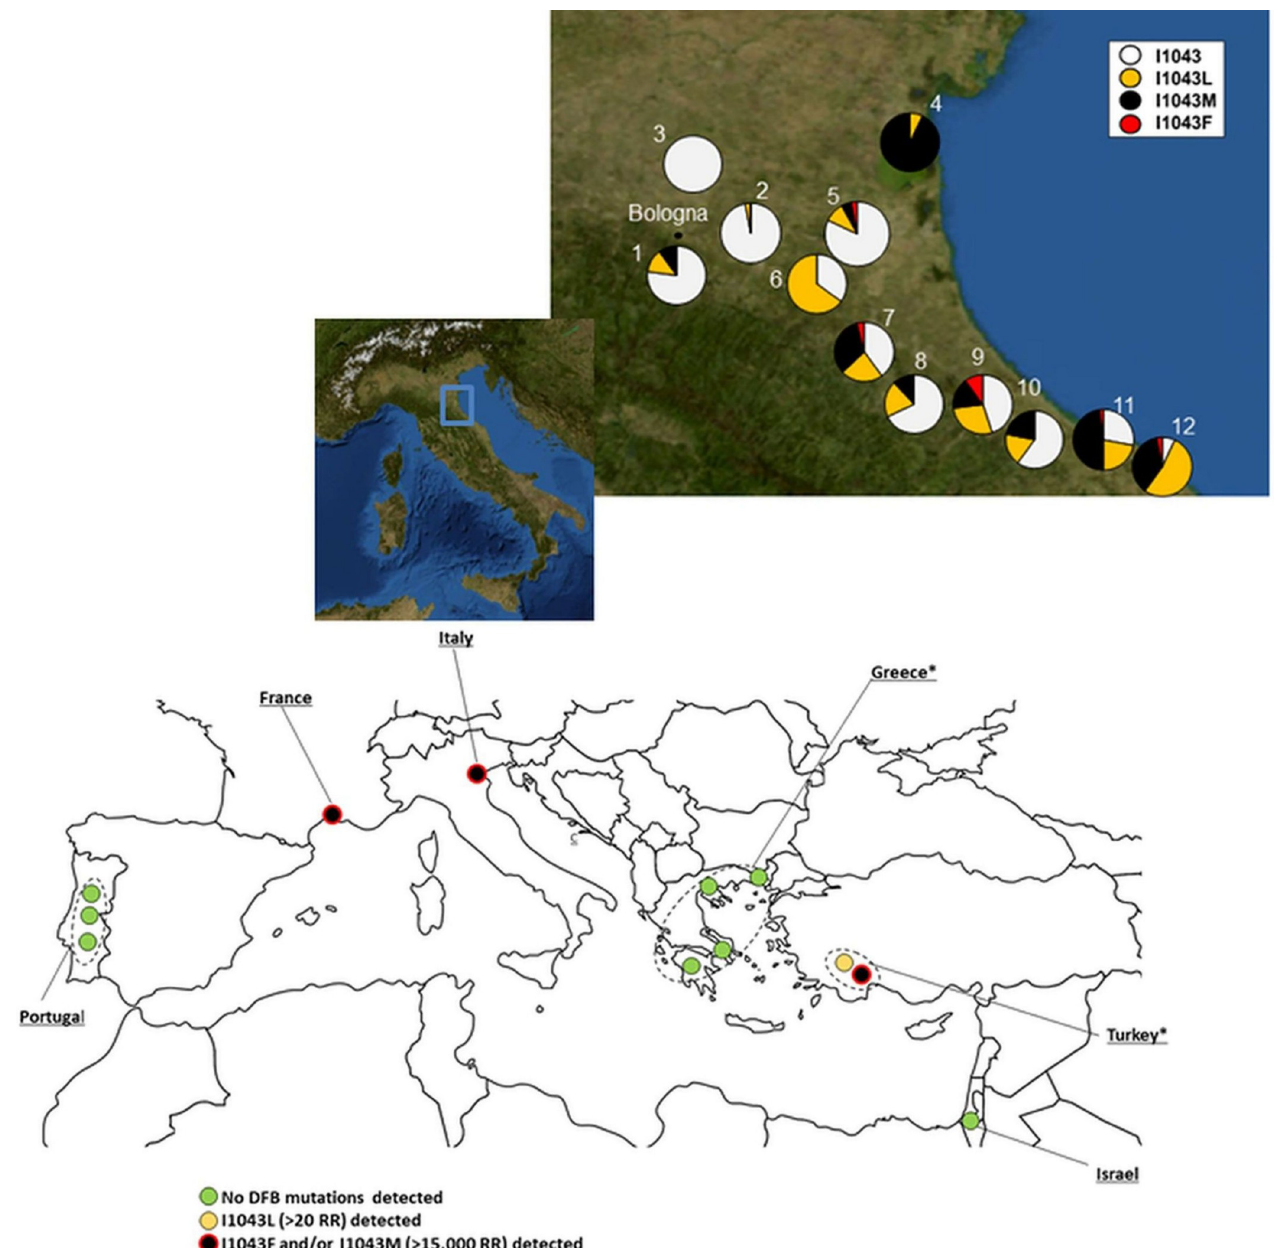
Fig 1. Distribution of DFB resistance mutations in Cx . pipiens populations in the Mediterranean basin (bottom) and relative frequencies of the susceptible and resistant alleles found in populations of Cx . pipiens collected from the Emilia-Romagna provinces, Italy (2018) (top)—(map images were obtained from [12]). Sampled localities in Italy are numbered according to Table 1. � DFB resistance mutation analyses in Cx . pipiens populations from the Peloponnese, Greece and Mugla Province, Turkey were conducted in [13] and [9], respectively.